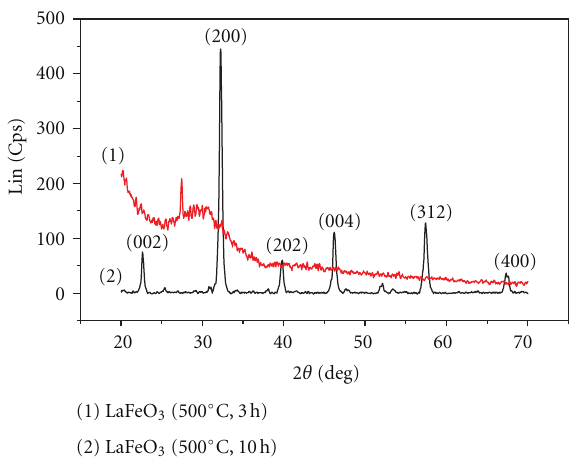
Figure 5: The powder X-ray di ff raction patterns of gel complex heated at 500 ◦ C for 3 hours (red line) and for 10 hours (black line).